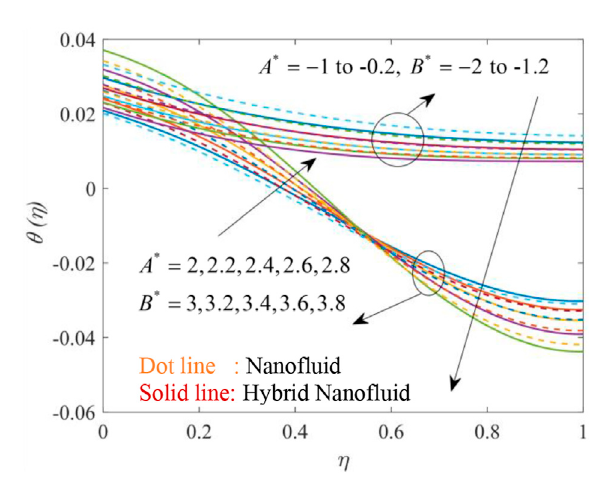
FIGURE 15 Effect of thermal relaxation parameter τ E on θ ( η ) .